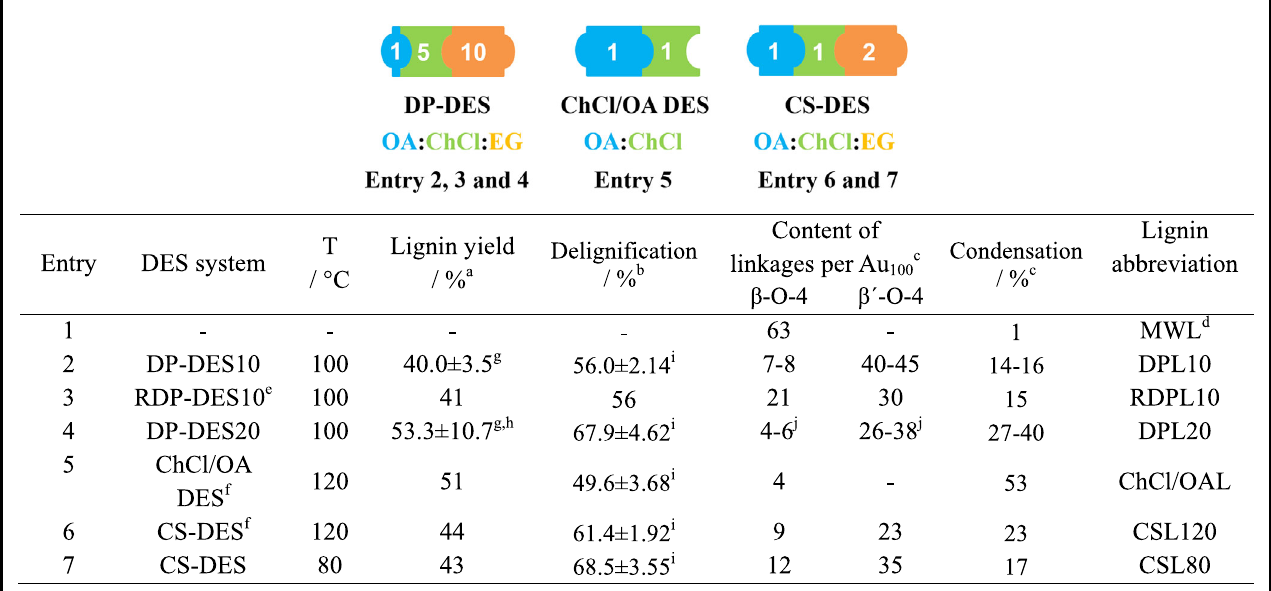
General conditions : 2g birch lignocellulose was used for fractionation in ~32g DP-DES at 80 – 100°C for 24h. After fractionation, the obtained lignin was isolated by THF/water extraction method. a The yield of lignin was calculated based on the Klason lignin content in birch after correcting for the alcohol incorporation 45 .